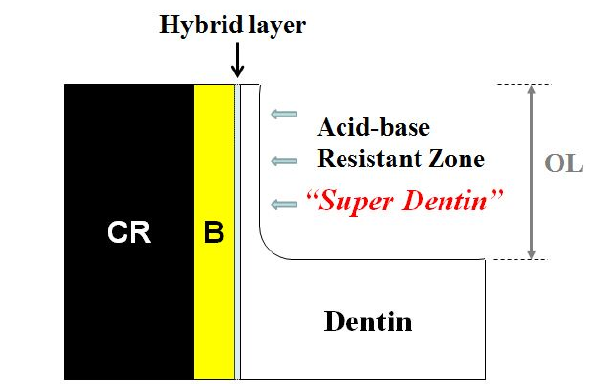
Figure 3. Acid-base resistant zone (ABRZ) is created beneath the hybrid layer, which is expected to resist against demineralization from an acid attack from the microorganisms in primary and secondary caries. The reinforced dentin was proposed to be called as “Super Dentin”. CR; resin composite, B; bonding resin, OL; outer lesion.